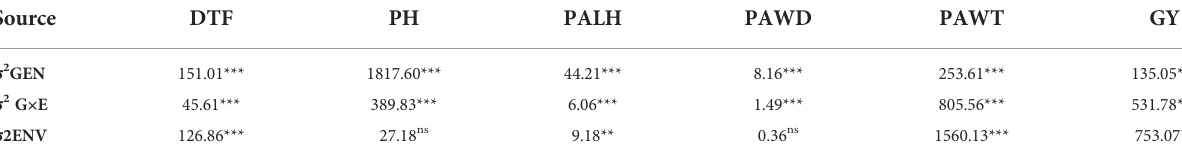
TABLE 1 Combined analysis of variance for grain yield and other target traits for sorghum accessions grown at three locations. Source